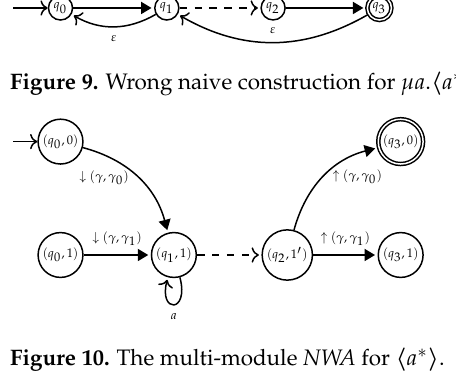
expression. a ∗ (cid:104) (cid:105)